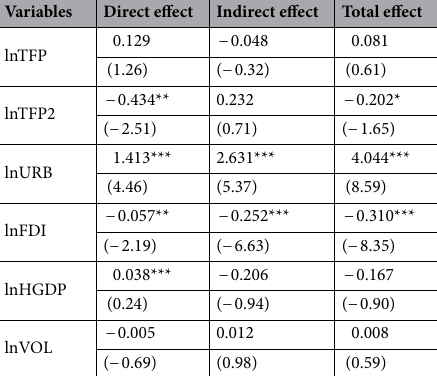
Table 9. Results of direct effects, indirect effects and total effects for